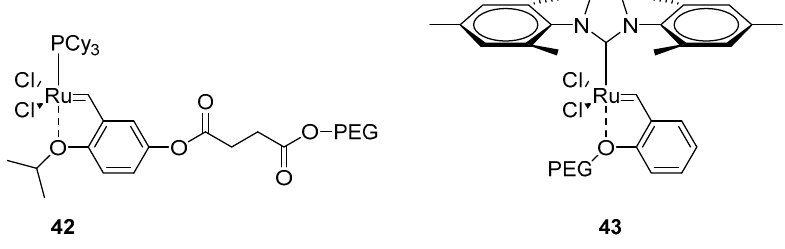
Figure 8. PEG-supported Hoveyda-Grubbs catalyst 42 and 43 .